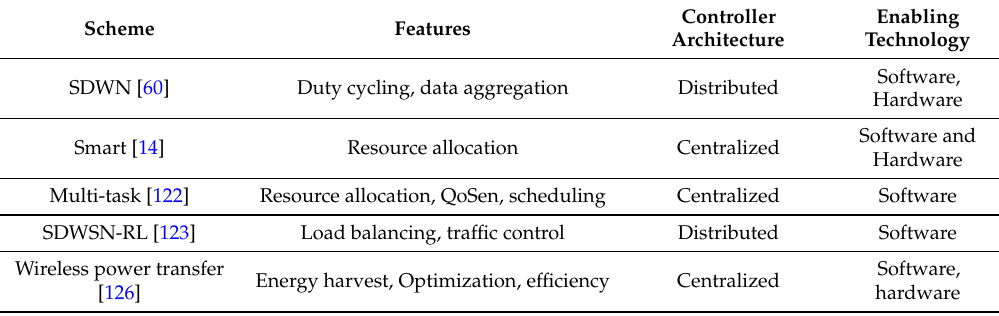
Table 3. SDN-based Energy management schemes for